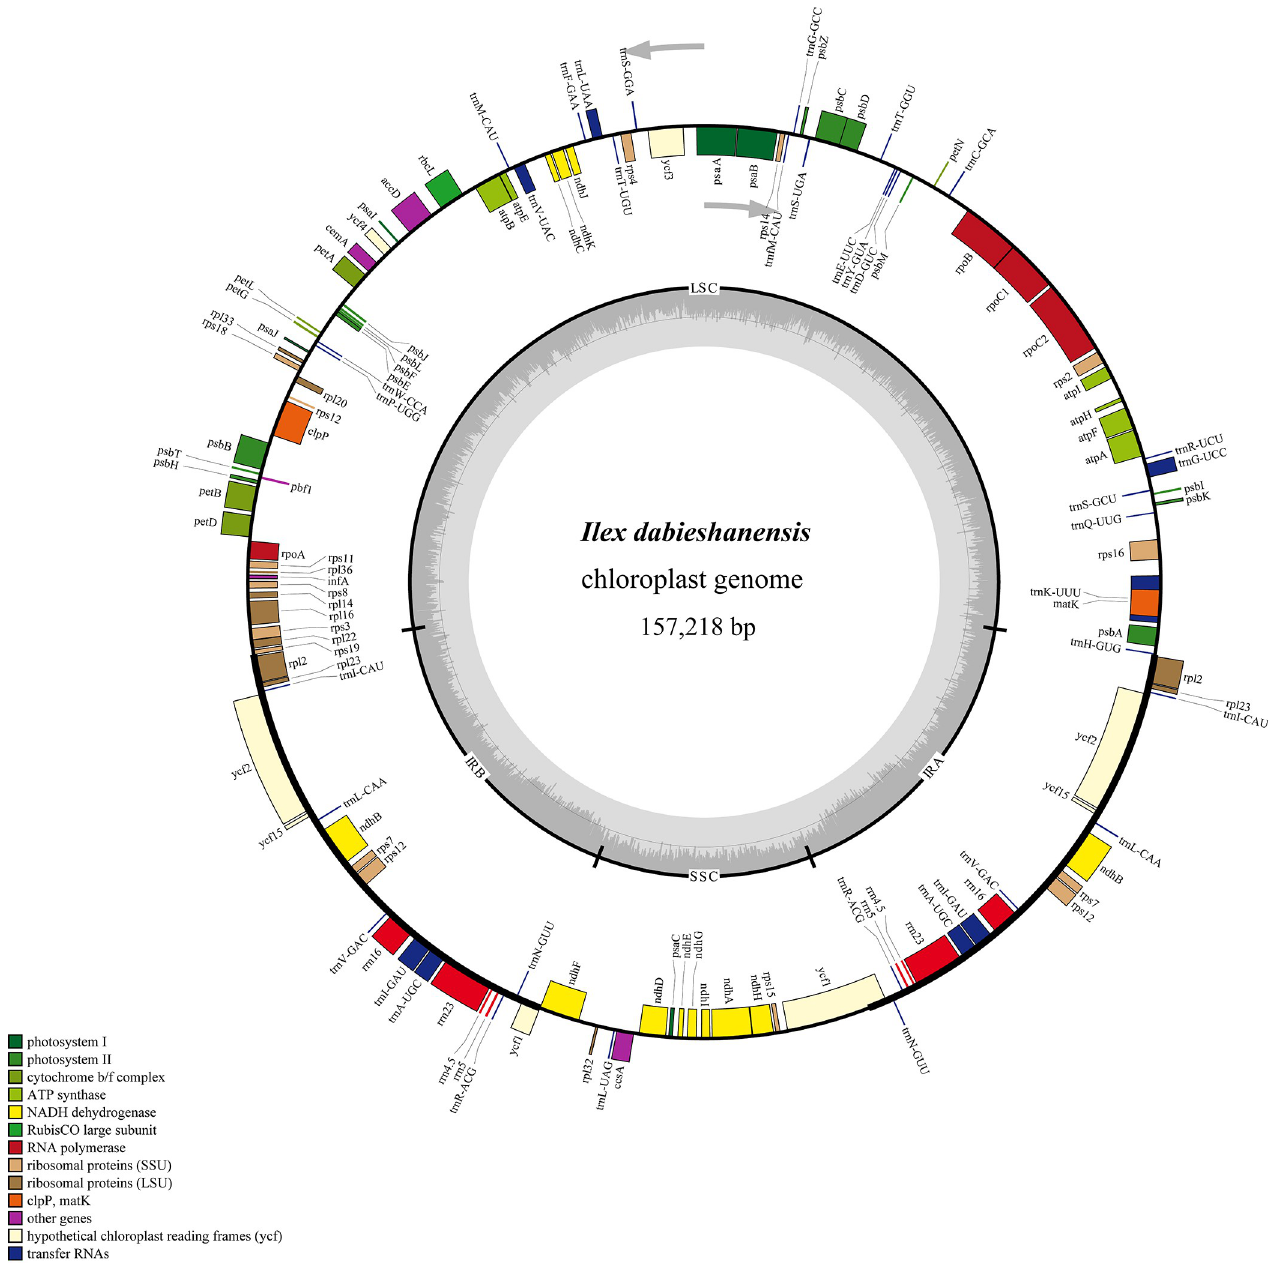
Fig 1. Circular gene map of I . dabieshanensis chloroplast genome. The gray arrowheads indicate gene directions. Genes inside and outside the circle represent transcribed clockwisely and counterclockwisely. Different functional genes are color coded. The innermost darker gray conforms to GC content, whereas the lighter gray conforms to AT content. LSC, large single copy region; SSC, small single copy region; IR, inverted